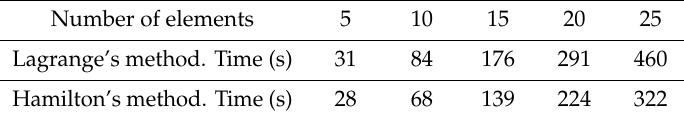
Table 3. Calculation times for the two methods.